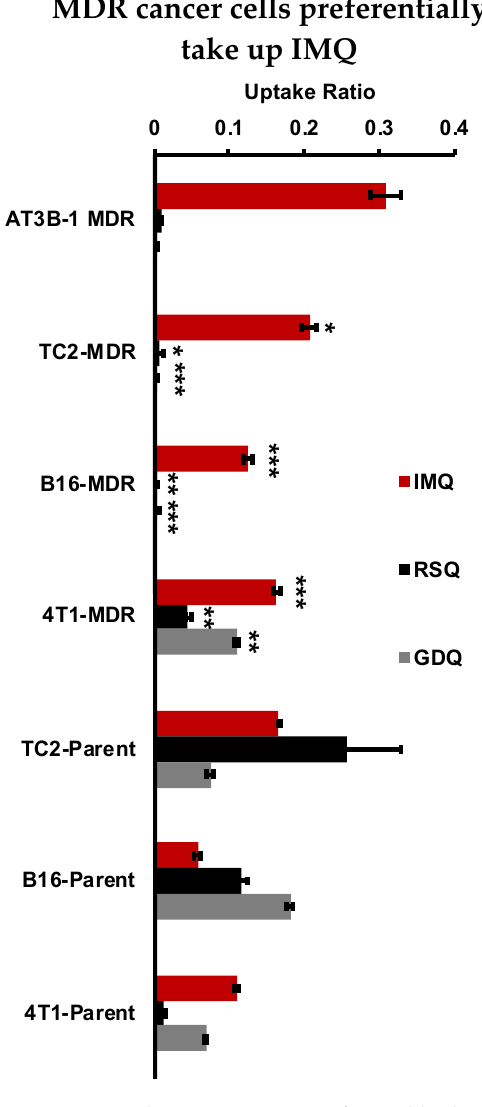
Figure 5. Uptake experiments performed by loading IMQ, RSQ, or GDQ (100 µ M) under passive diffusion conditions in parent and MDR-derived cancer cell lines followed by analysis of imidazoquinoline in cell lysate by HPLC. Cellular uptake ratio was calculated by dividing the peak area of substrate in lysate by the peak area calibrated for 100 µM imidazoquinoline using standard solutions. Data representative of experiments performed in triplicate. p -values were calculated between parent vs. MDR cancer cell lines with * p < 0.05, ** p < 0.01, and *** p < 0.001.